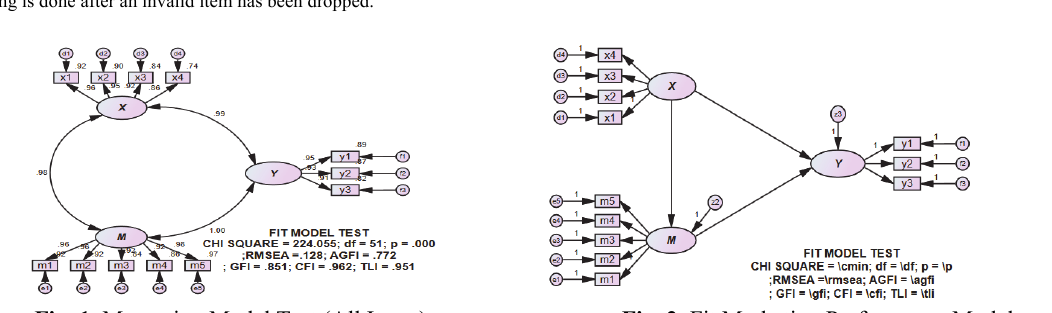
Fi g. 1. Measuring Model Test (All Items) Fig. 2. Fit Marketing Performance Model